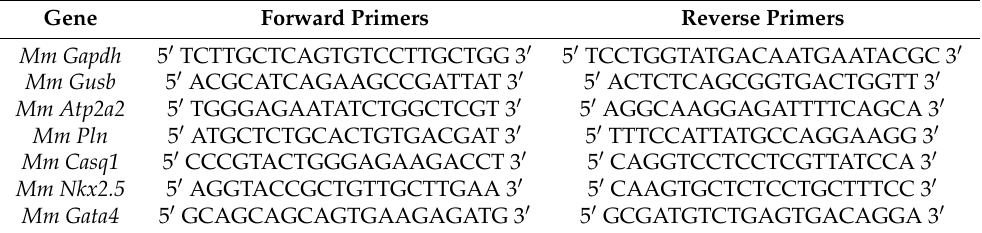
Table 2. Primer sequences used for qPCR in HL-1 cardiomyocyte